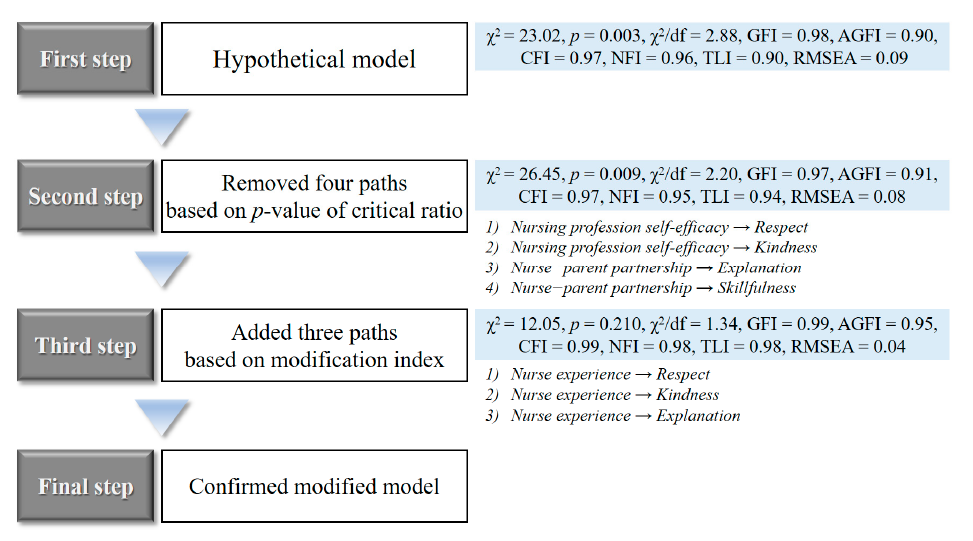
Figure 2. Flow of modification in this study.